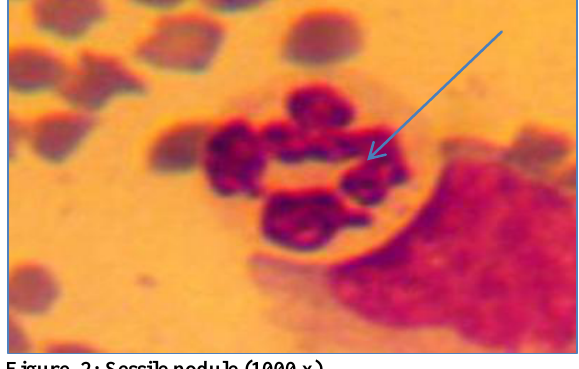
Figure, 2: Sessile nodule (1000 x)